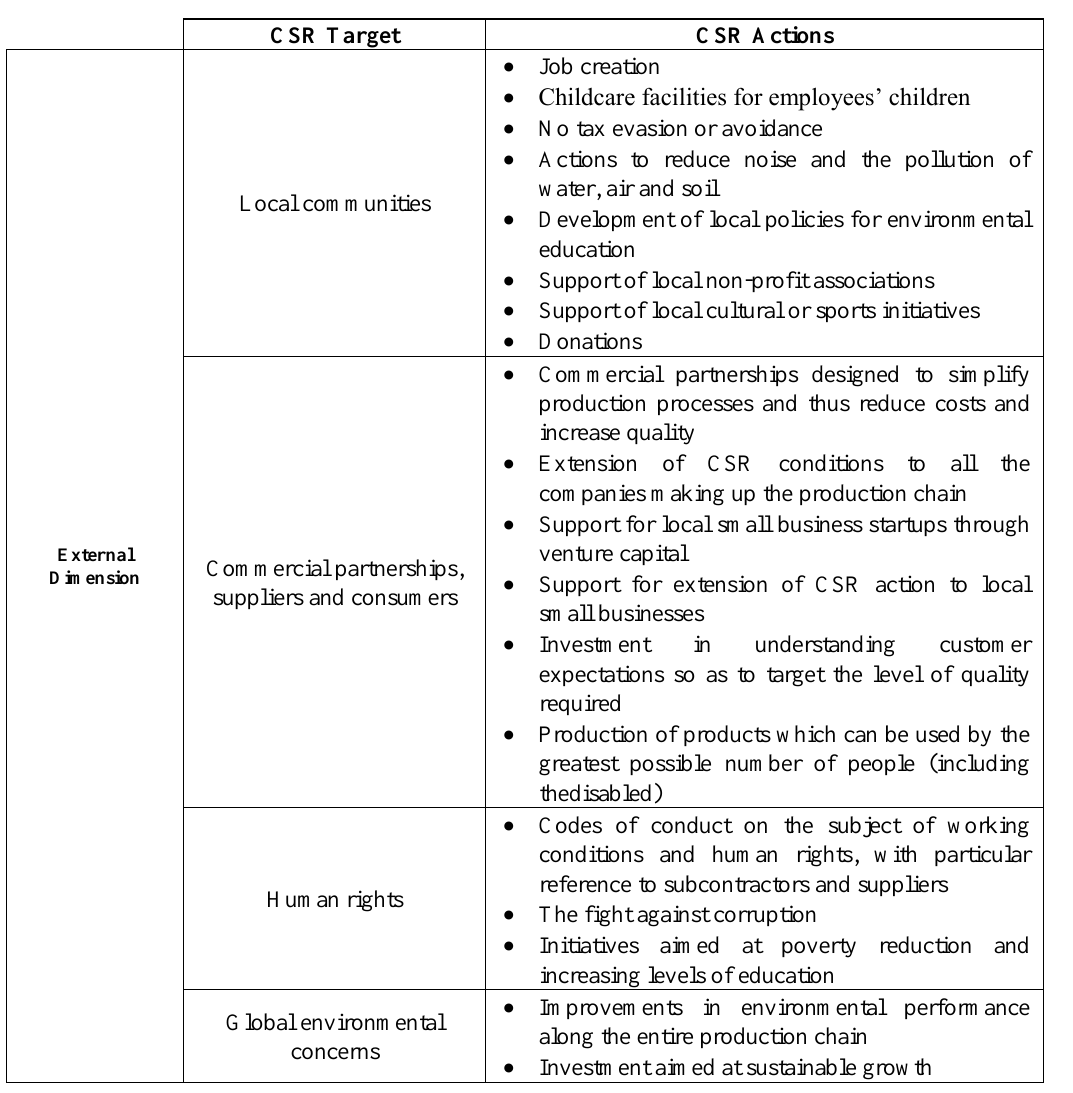
Figure 4: Corporate Social Responsibility: the External